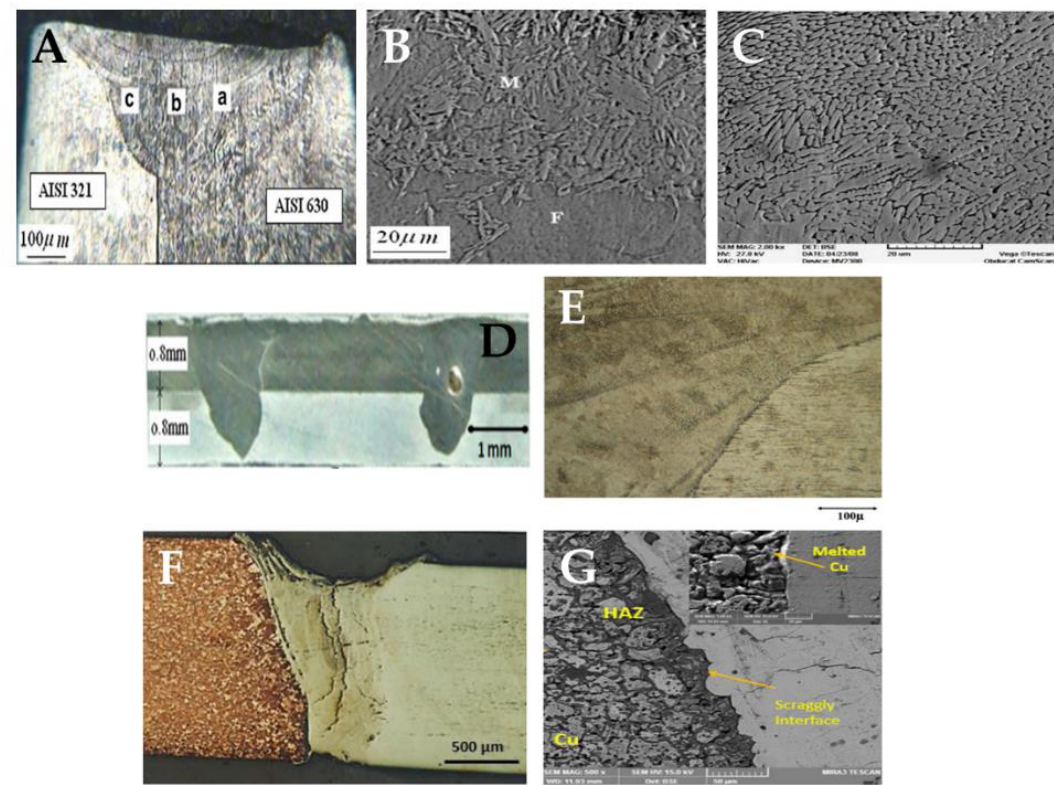
Figure 10. Pulsed laser weldments made of dissimilar stainless steels: AISI 321 and AISI 630 ( A ), its FZ in the AISI 630 ( B ) and AISI 321 ( C ) sides [63], AISI 304L and DIN 11010 ( D ) and its FZ ( E ) [65], AISI 304 and copper pure ( F ) and its weld interface ( G ) [66].